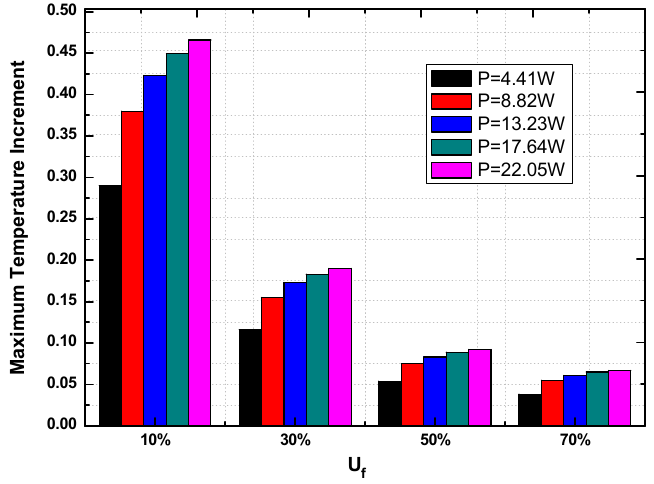
Figure 13. The effect of heating uniformity on maximum temperature of TEG.